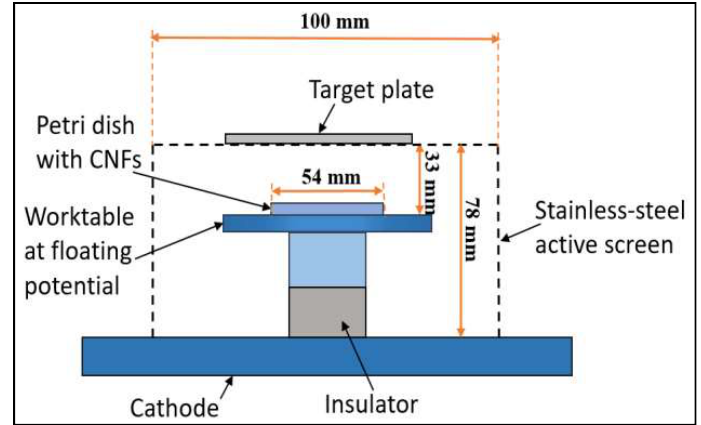
Figure 1. Schematic diagram of the active-screen plasma sputtering (ASPS) setup inside the plasma furnace. Table 1. Experimental conditions of active-screen plasma sputtering (ASPS)